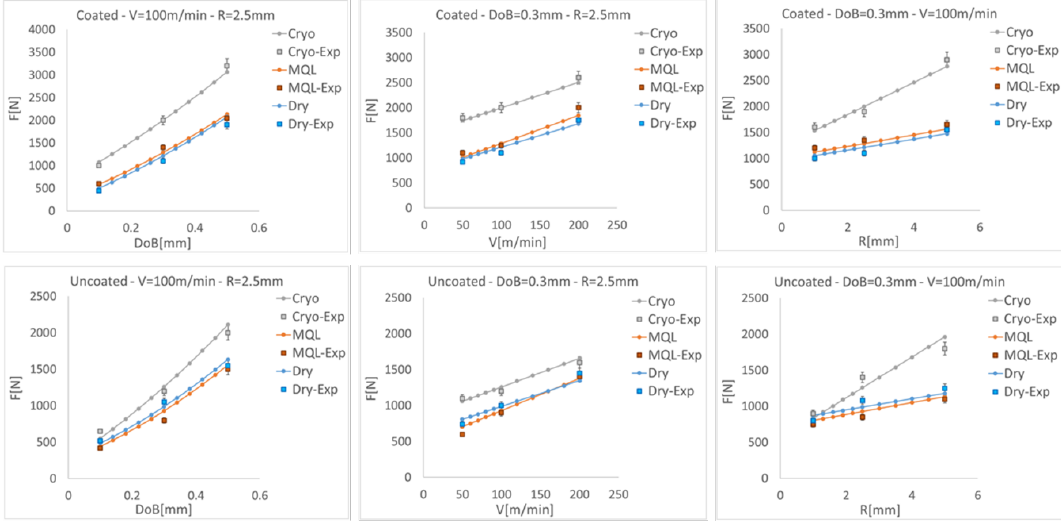
Figure 9. Model prediction for forces vs. experiments.